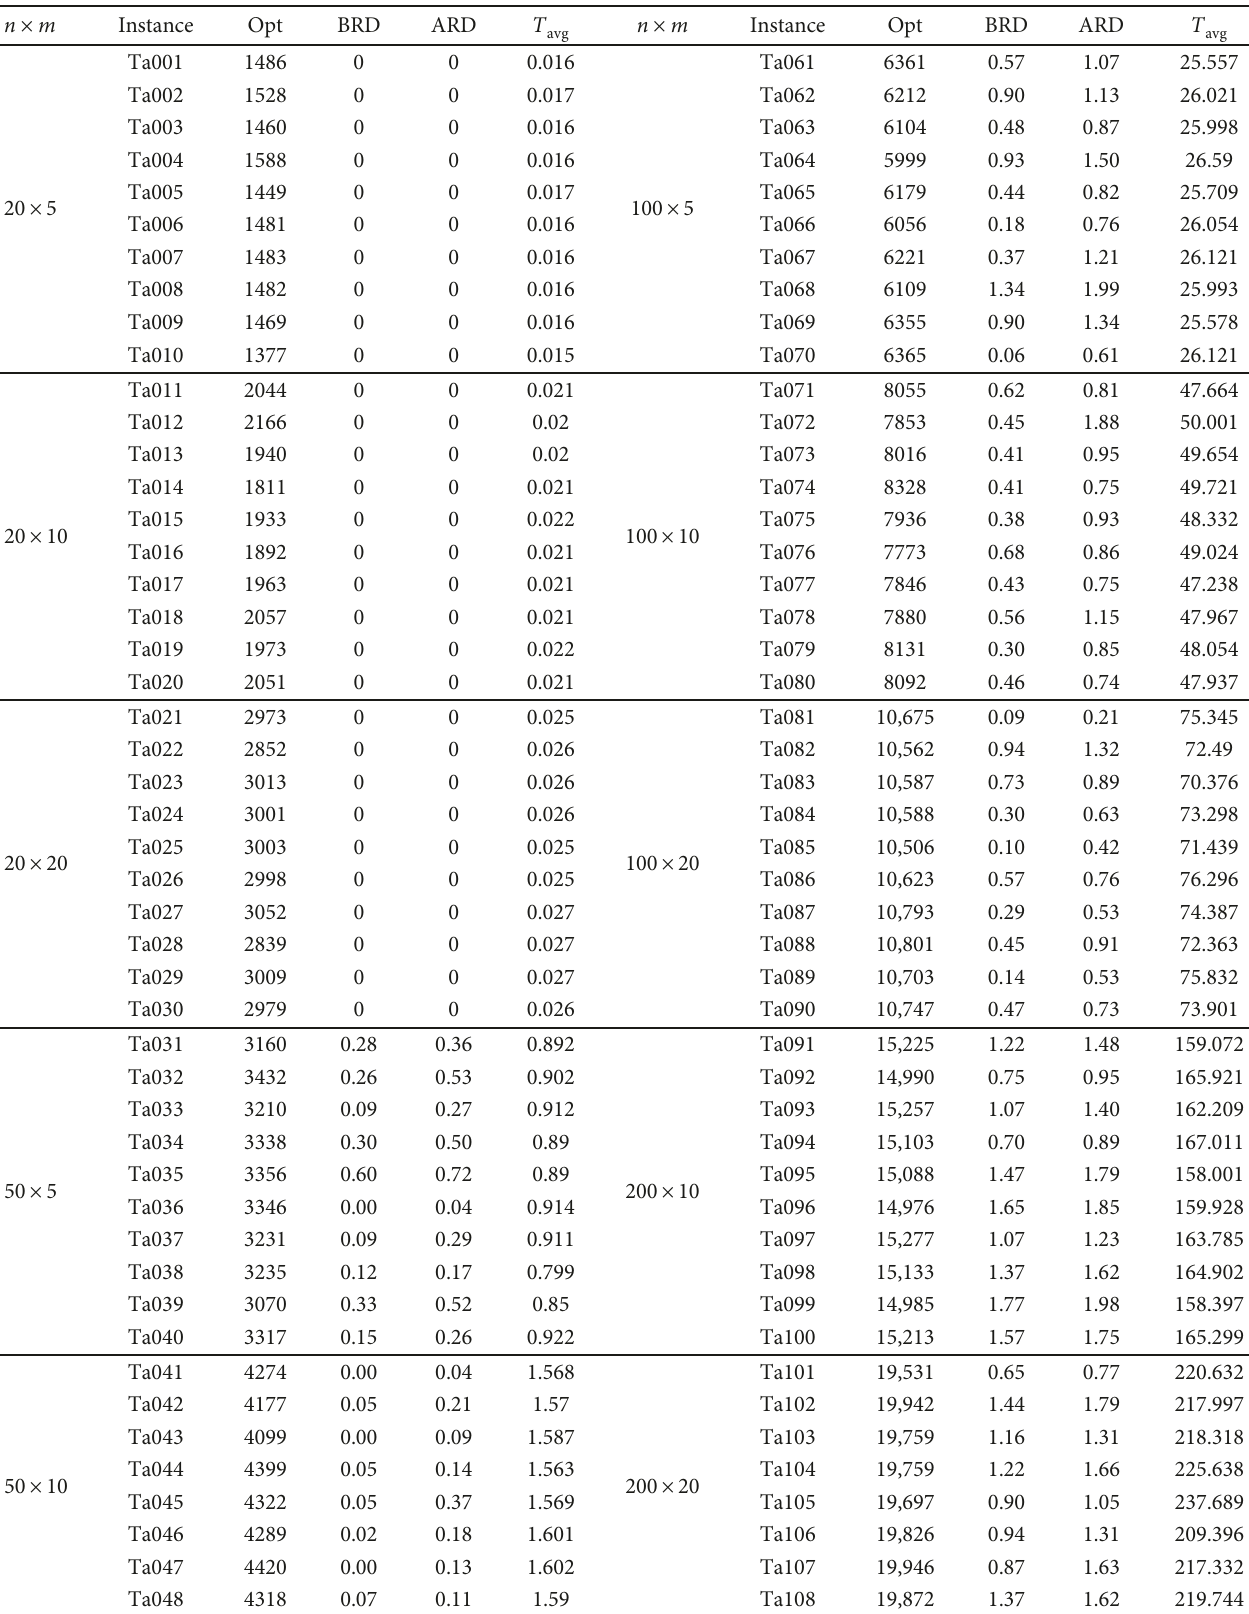
Table 7: The HMM-PFA statistical result to solve 120 Taillard ’ s benchmark